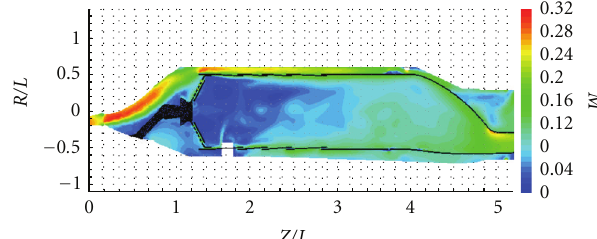
Figure 6: Mach number contours along the middle longitudinal plane.